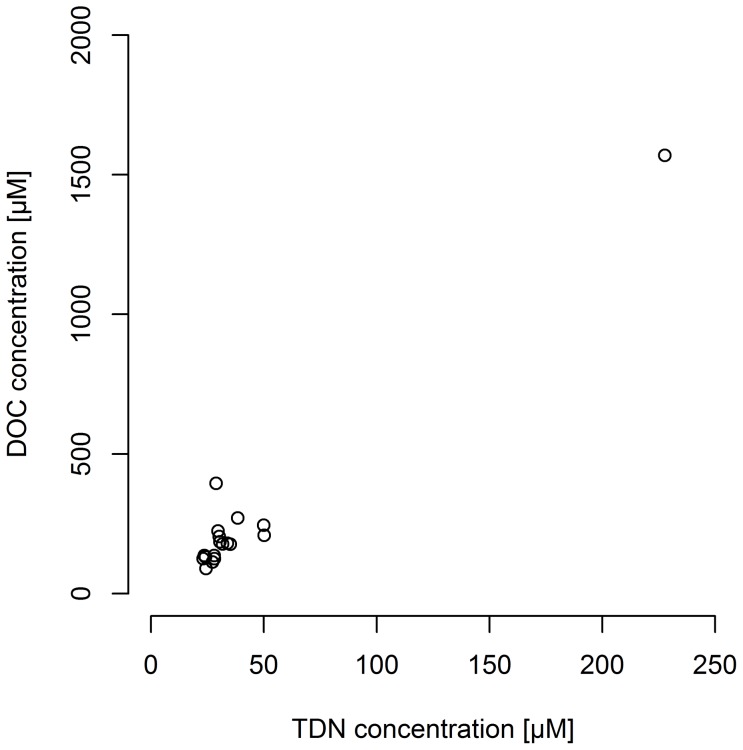
The correlation between DOC and TDN.Dissolved organic carbon (DOC) is presented as a function of dissolved total nitrogen (TDN). The DOC and TDN concentrations were significantly correlated (Spearman's rank correlation coefficient, rho = 0.749, p<0.001, n = 18).